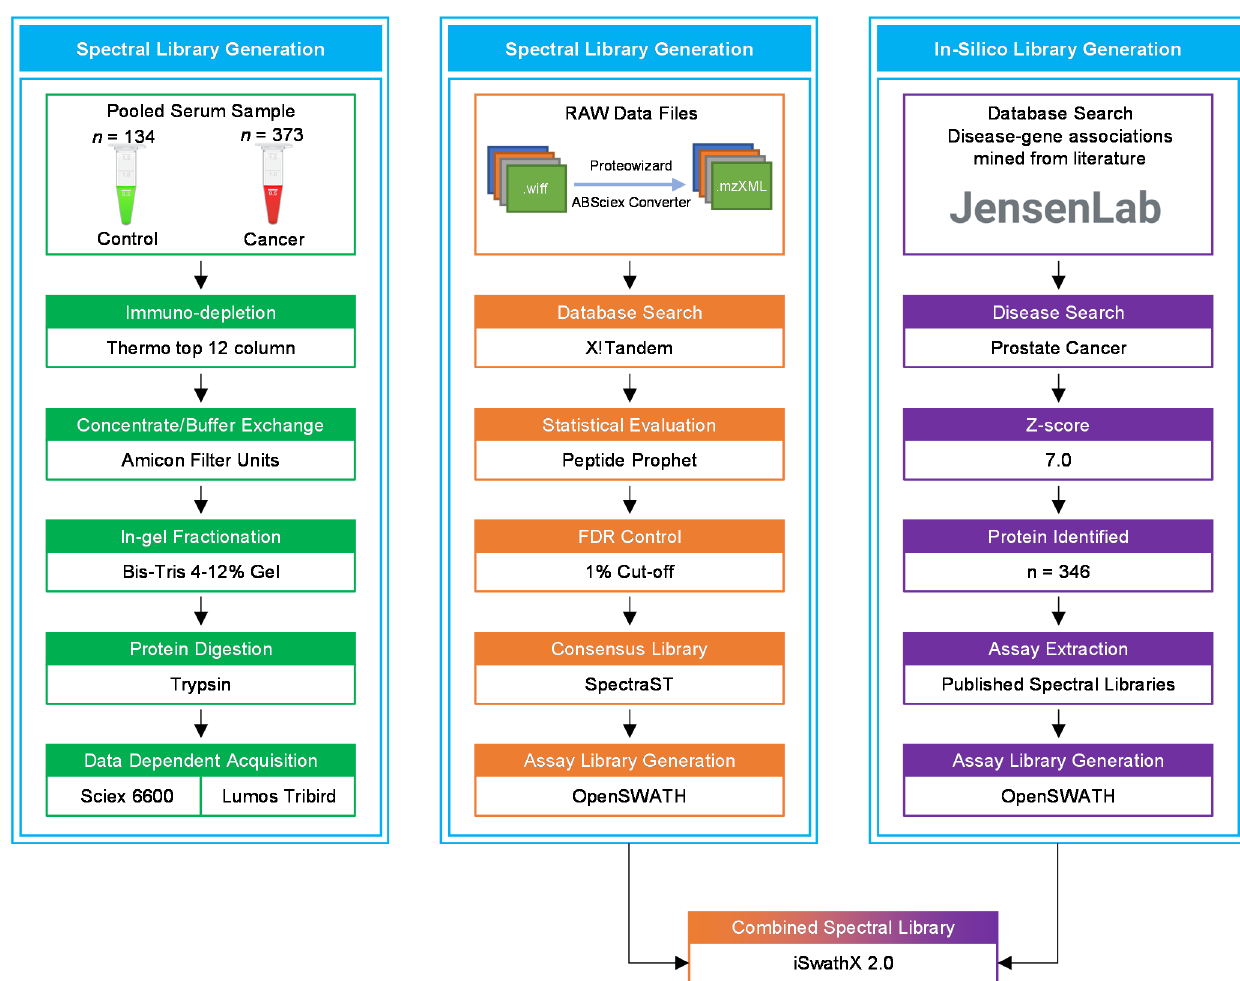
Figure 8. A flowchart of the data acquisition and spectral library generation workflow. The pooled samples were immuno- depleted of the top 12 abundant proteins, followed by protein concentration, in-gel fractionation, and in-gel tryptic digestion. All samples were analysed using LC-MS/MS for data dependent acquisition (DDA). In the OpenSWATH library generation pipeline, X!Tandem was utilised for database search of raw MS files. The in silico library was created by extracting PCa-related proteins from the Disease database using a z-score cut-off of 5.0. iSwathX, a web-based tool, was used to merge all four assay libraries.